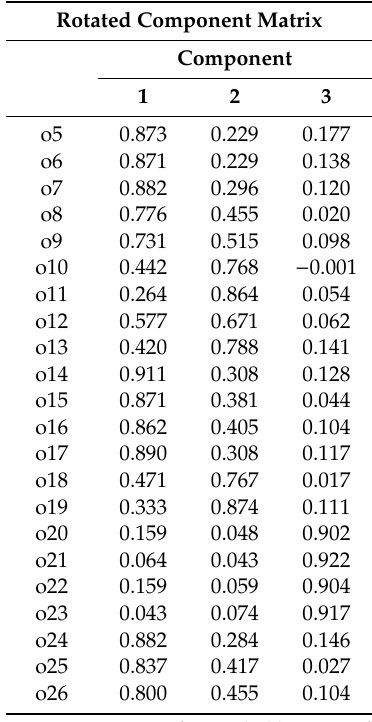
Figure 4. Scree plot analysis of examined motivational factors (source: own processing according to SPSS statistical program). Table 3. Rotational matrix of key motivation factors.